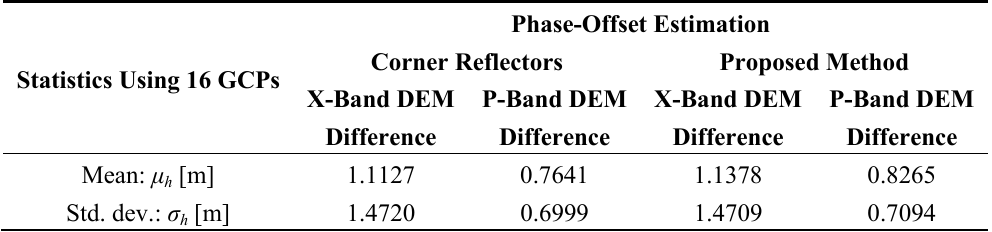
Table 4. DEM error in relation to 16 GCPs in the test site area measured with GPS